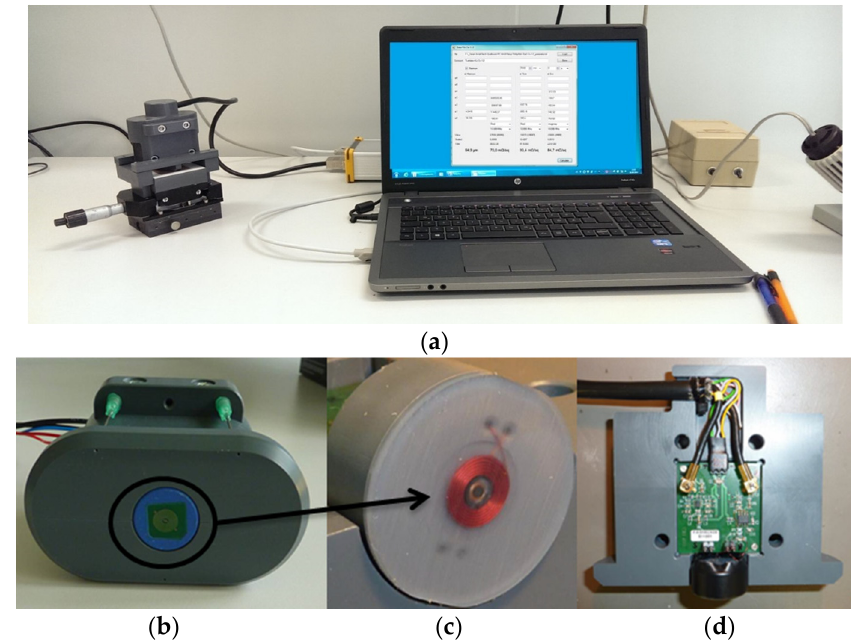
Figure 4. Photographs of the high ‐ frequency eddy current (HFEC) system based on the EddyCus ® System ( a ), sensor ‐ box ( b ), coils configuration ( c ), and preamplifier inside of the sensor ‐ box ( d ).